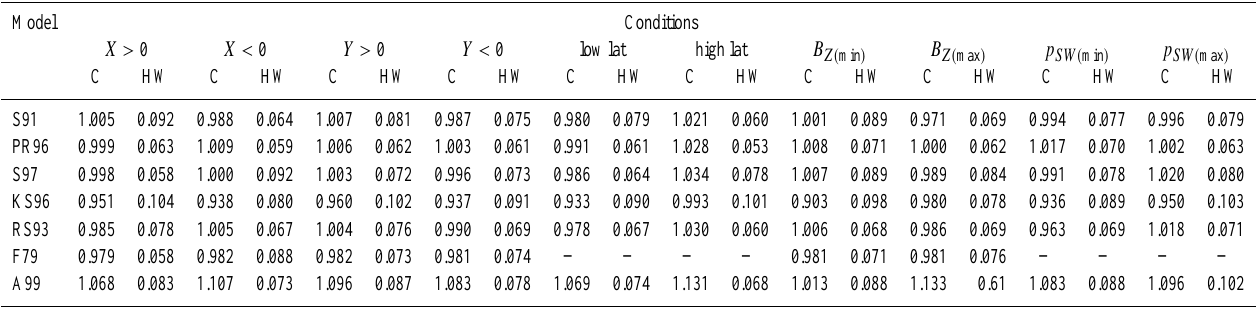
Table 5. Comparison of models under different constraints ( X , Y , Z – aberrated coordinates; C – center of distribution; HW – half-width of distribution of R mod /R obs ratios)